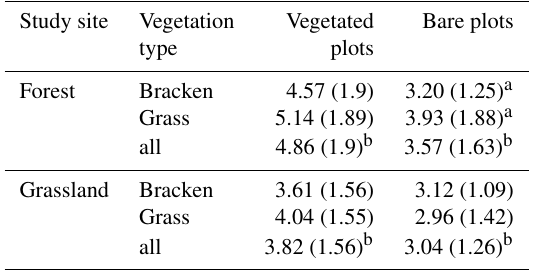
Table 2. Total average CO 2 effluxes (µmolm − 2 s − 2 ) from plots un- der bracken and grass understorey with vegetated and bare plots at the forest and grassland study